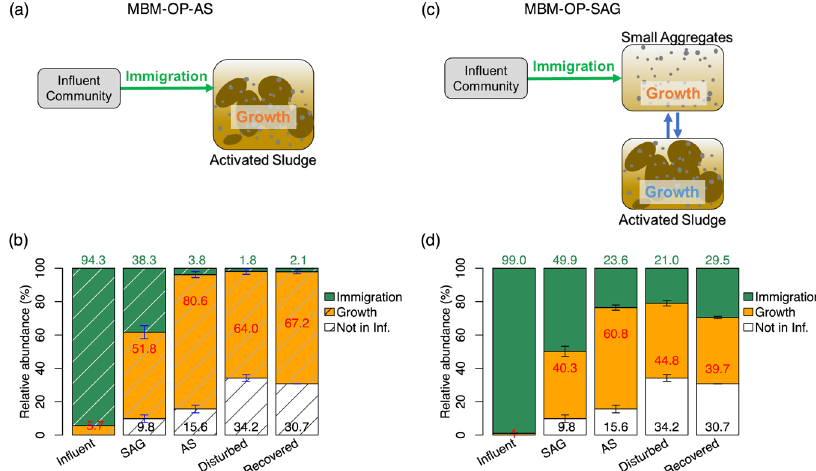
Fig. 2 Contributions of immigration and growth for community recovery after disturbance. a In fl uent to AS immigration model. b Proportions of the immigration and growth groups calculated by MBM-OP-AS model using the relative abundances of OTUs in in fl uent and AS. c Proposed in fl uent to small aggregates immigration model. d Proportions of the immigration and growth groups calculated by MBM-OP- SAG model using the relative abundances of OTUs in in fl uent and small aggregates. Error bar represents standard deviation of n samples ( n = 2 for in fl uent; n = 6 for SAG and AS; n = 2 for disturbed and